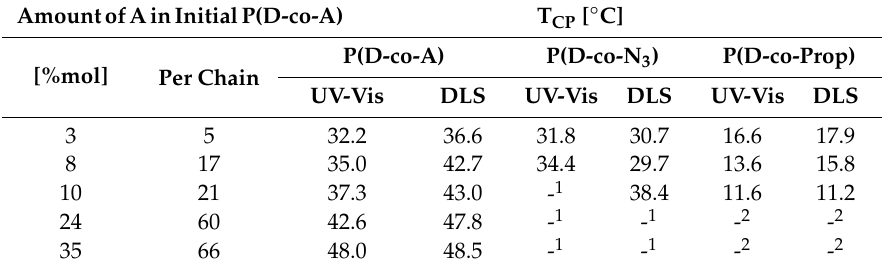
Table 2. Cloud point temperatures for water solutions of P(D-co-A), P (D-co-N 3 ), and (P(D-co-Prop) at chosen copolymer concentration of 1.0 g / L, determined via UV-Vis and DLS measurements. AmountofAinInitialP(D-co-A)